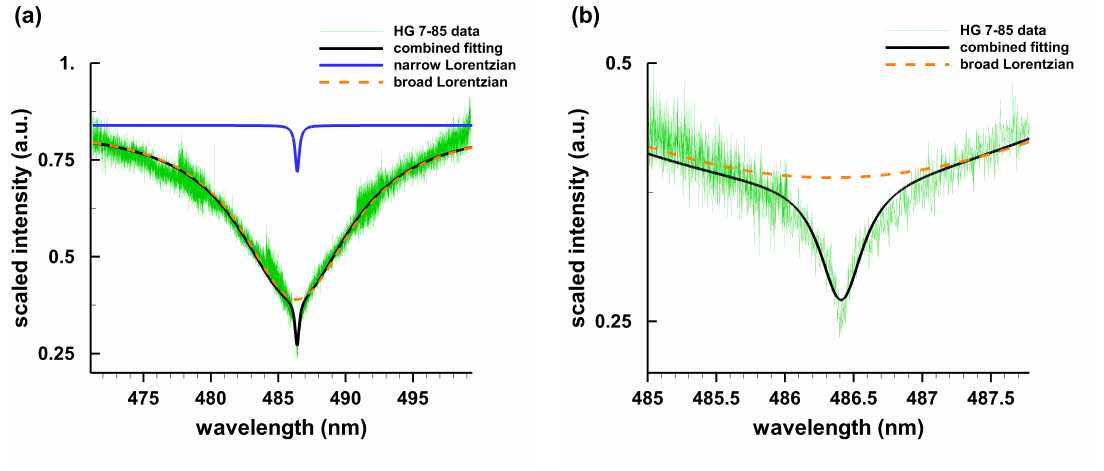
Figure 6. Hyades cluster white dwarf HG 7-85, recorded with a resolving-power 40,000 Echelle-spectrometer: ( a ) H β expanded region; and ( b ) H β center